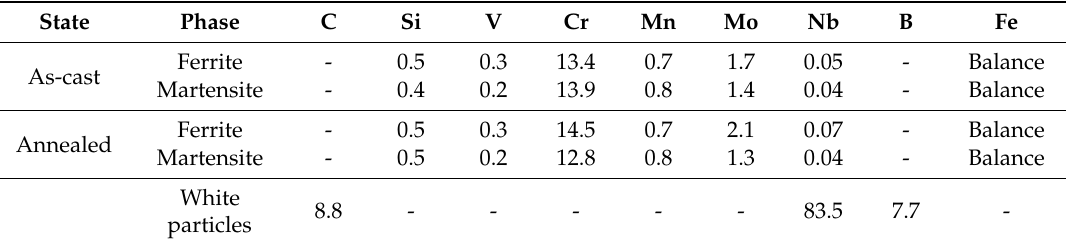
Figure 1. Microstructure of 13CrMoNbV steel (SEM) ( a ) as-cast and ( b ) after the annealing at 1250 ◦ C for 5 min. Table 2. Chemical composition of the phases in the microstructure of 13CrMoNbV steel (wt. %).